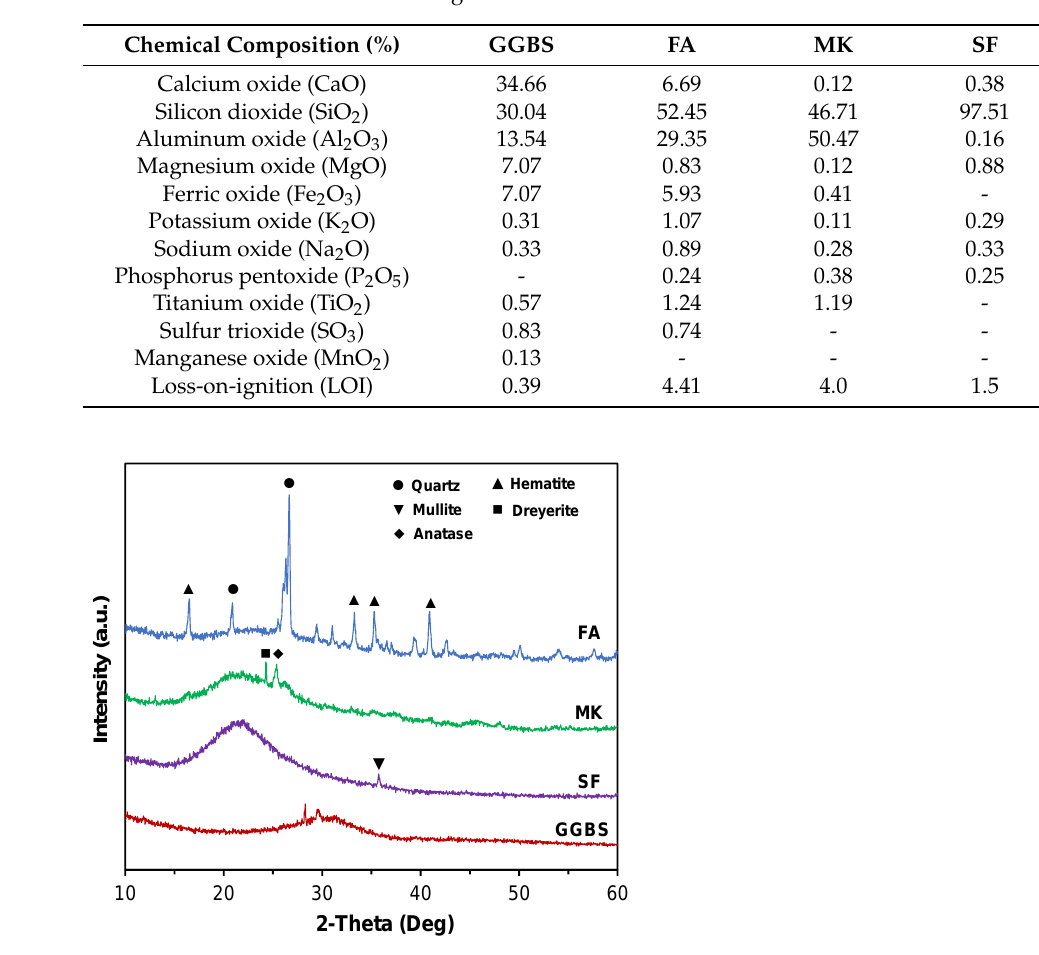
Table 2. The chemical structure of slag and mineral admixtures.